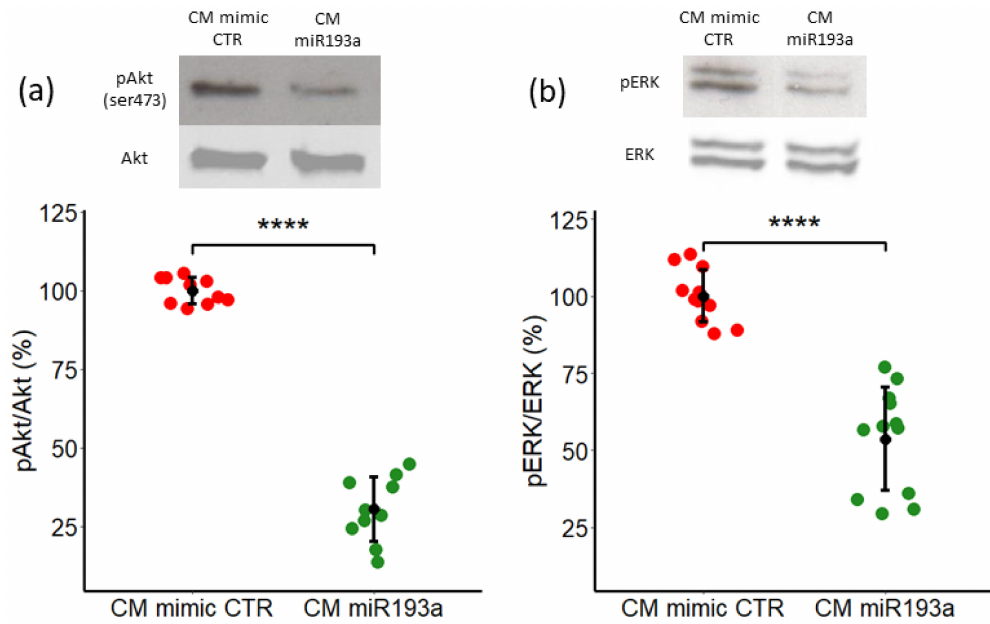
Figure 6. Secretome/CM from miR193a-3p transfected MCF-7 cells inhibits PI3k/Akt and ERK1/2 phosphorylation in VECs. Representative Western Blots and graphs depicting the effects of secretome from miR193a-3p transfected MCF-7 cells on Akt ( a ) and ERK1/2 ( b ) phosphorylation in VECs, after culturing in CM miR193 for 45min. Total Akt and ERK 1/2 was used as loading control. Western blot analysis is performed on whole cell lysate from VECs in CM miR193a/CM mimic CTR. Experiments were performed at least 3 times in triplicates or quadruplicates and data are represented as mean ± SD. p < 0.0001 **** compared to the respective control.